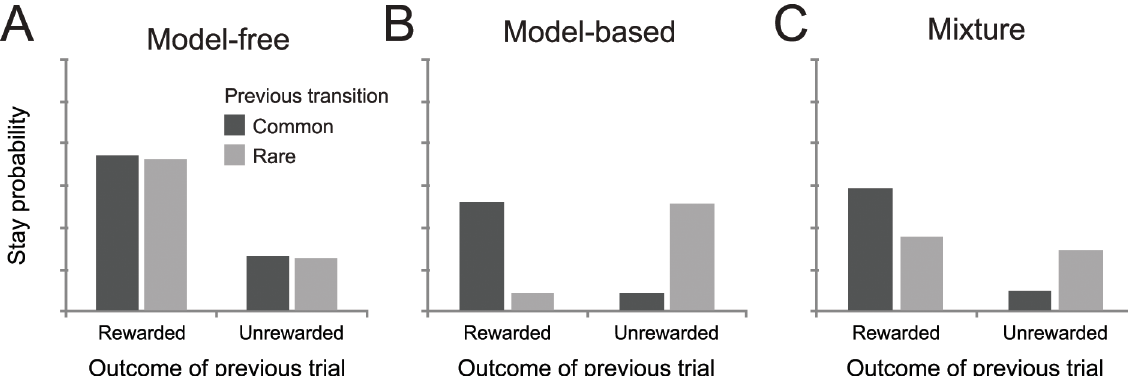
Fig 2. Probability of repeating the first-stage choice for three agents. (A) For model-free agents, the probability of repeating the previous choice is dependent only on whether a reward was obtained, and not on transition structure. (B) Model-based behavior is reflected in an interaction between previous transition and outcome, increasing the probability of transitioning to the state where reward was obtained. (C) Behavioral performance on this task reflects features of both model-based and model-free decision making, the main effect of previous reward and its interaction with the previous